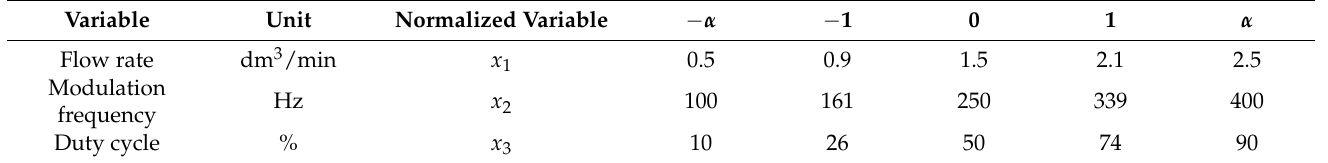
Table 1. Values of flow rate, modulation frequency and duty cycle in the CCI